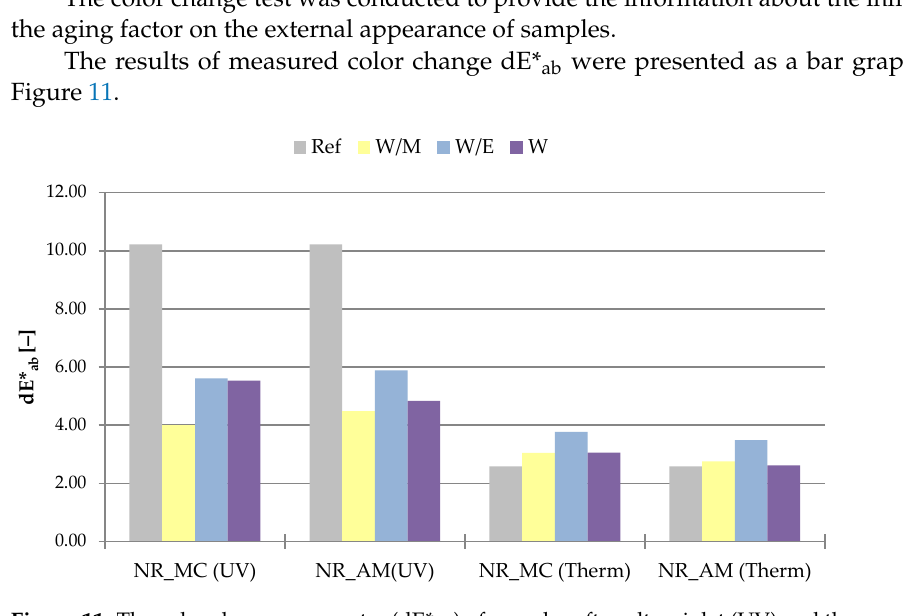
Figure 11. The color change parameter (dE* ab ) of samples after ultraviolet (UV) and thermo-oxidative (Therm) aging.